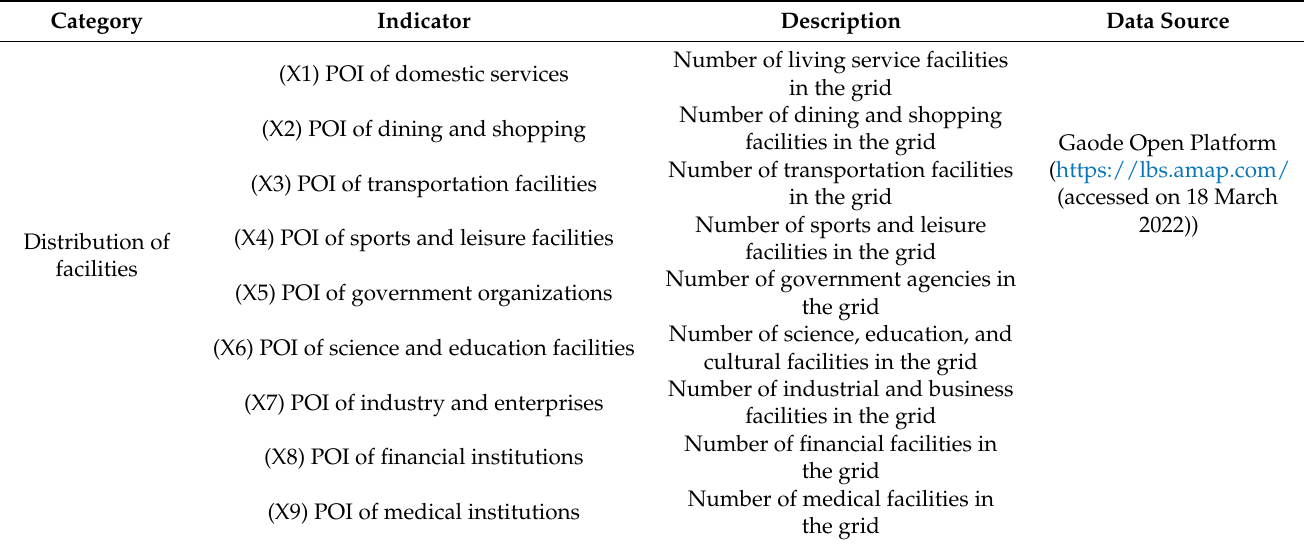
Table 2. Indicators and data sources of spatial